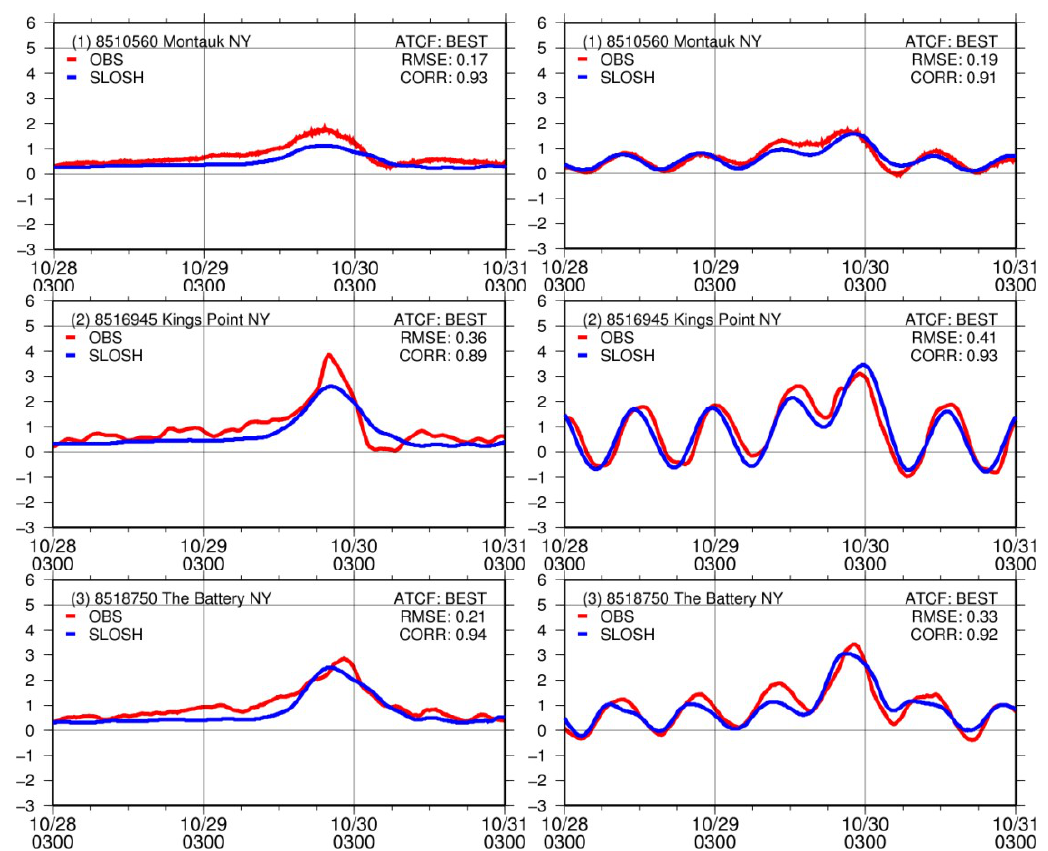
Figure 11. Hydrographs of surge (left panels ) and surge + tides ( right panels ) at NOAA stations ( red ) vs. SLOSH simulations ( blue ) with RMS error and correlation calculated between the two time series. Time is in month/day and hours UTC (horizontal axis) and water elevations are in meters (vertical axis). The station numbers in the time series plots correspond to the locations shown in Figure